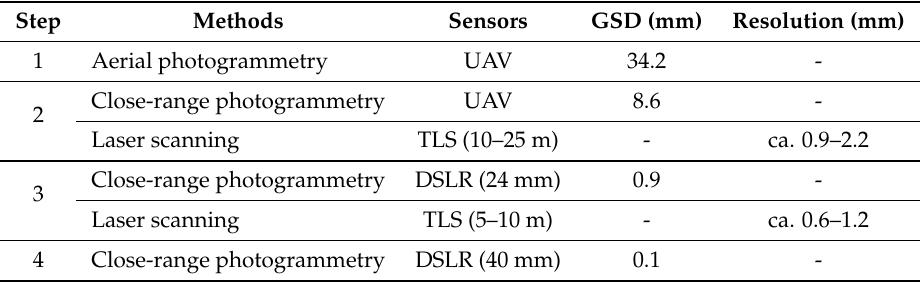
Table 1. The different scale steps in this project, with information on the methods used, sensors employed, and approximate GSD (for photogrammetry) and resolution (for TLS) for each